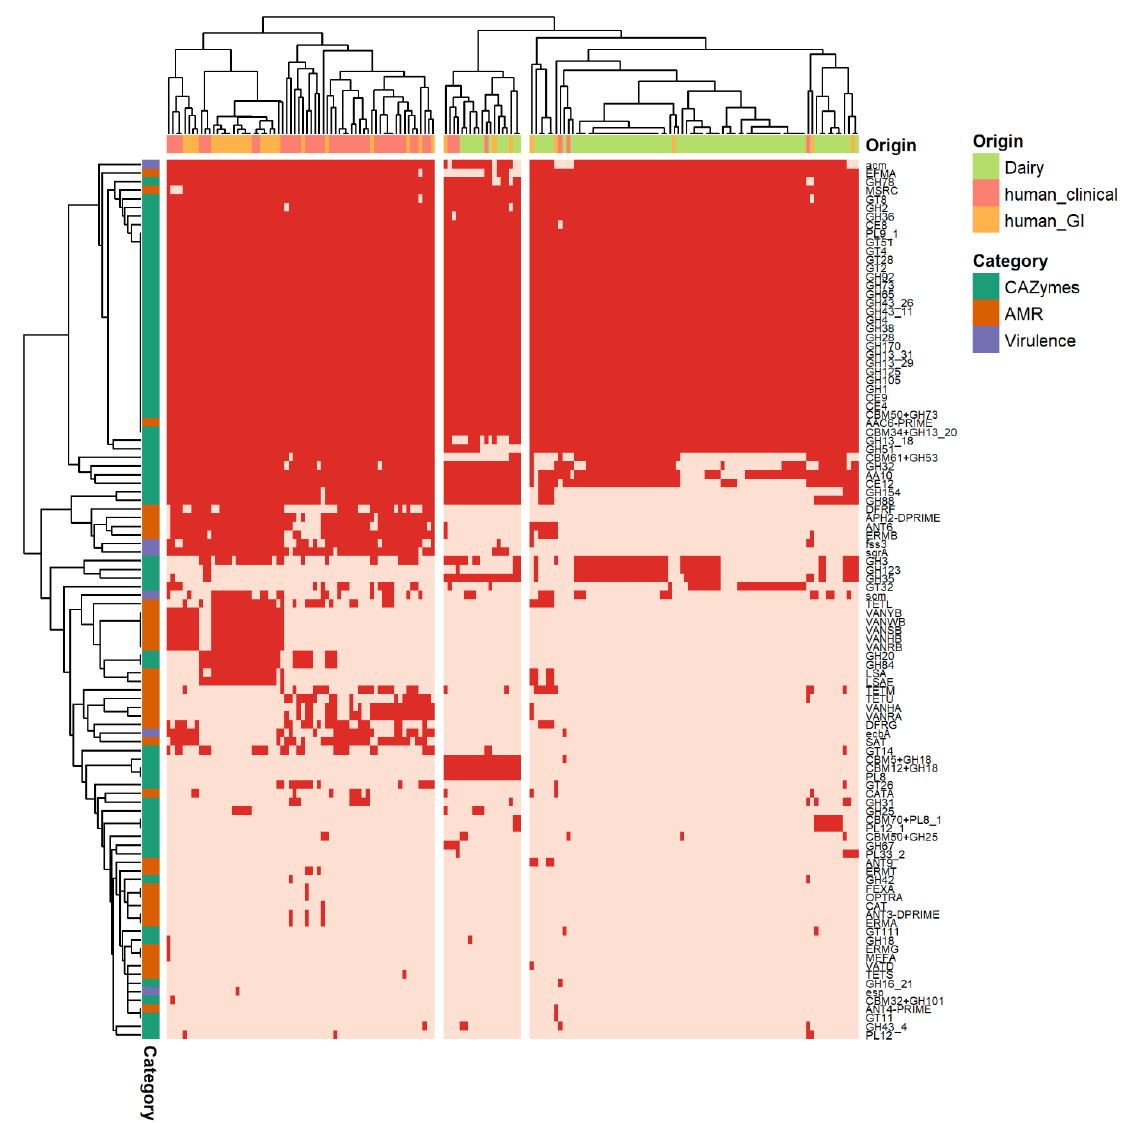
Figure 5. Cluster heatmap generated using a resistance, virulence and CAZyme gene presence-absence data matrix of E. faecium isolated from dairy, human-clinical and human-gastrointestinal origin.